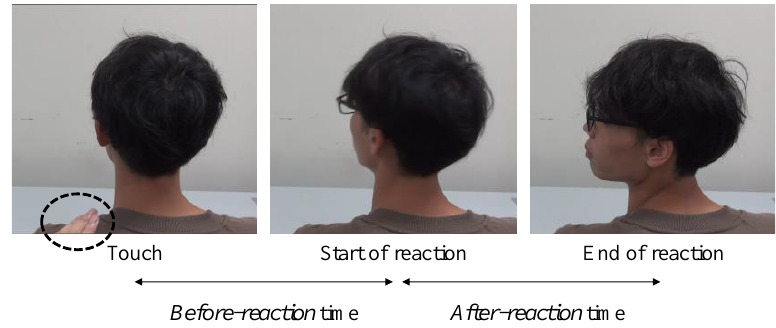
Figure 1. Before-reaction and after-reaction time concept.